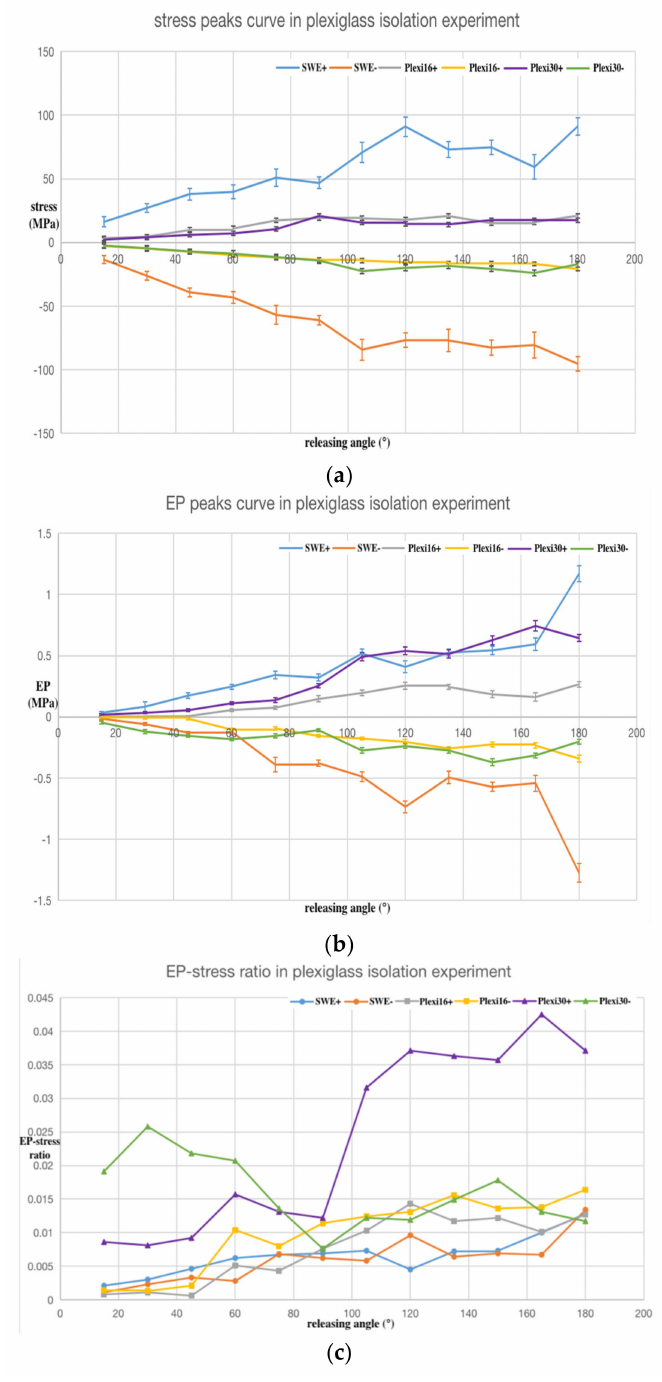
Figure 10. Analysis results of the Plexiglass isolation pedestal experimental data: ( a ) stress; ( b ) EP of the PPS output; ( c ) EP–stress ratio. The ordinate unit of (c) is